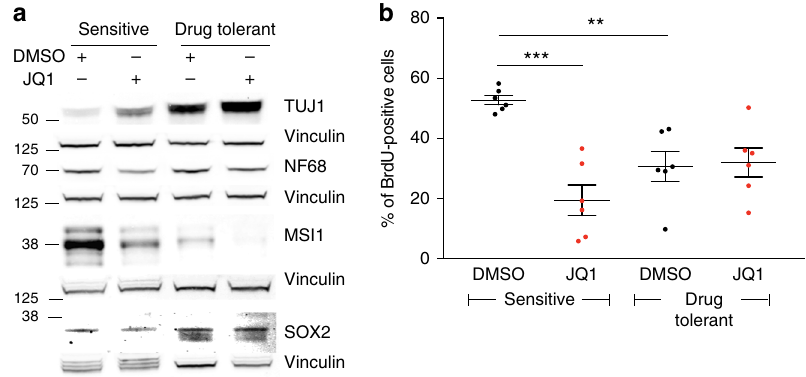
Fig. 7 Drug tolerant cells exhibit altered cell state. a Immunoblots for neuronal differentiation and stem markers in sensitive and drug-tolerant D458 cells in the presence of JQ1 (1 μ M) or DMSO control. Source data: Source Data File. b Percentage of BrdU positive D425 and D458 sensitive and drug-tolerant cells following 72 h of treatment with JQ1 (1 μ M) or DMSO control. Data represent three independent experiments per cell line; error bars depict mean ± SEM. Asterisks denote signi fi cant differences (* p < 0.05, ** p < 0.01, *** p < 0.001) as determined by two-tailed unpaired t -tests. Source data: Source Data